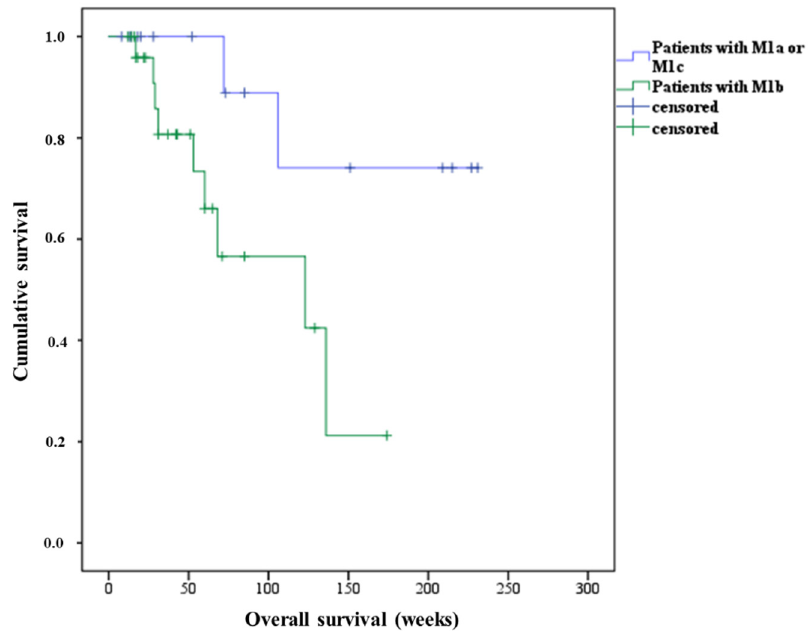
Figure 3. Kaplan–Meier plots using log-rank (Mantel–Cox) test illustrate overall survival of mCRPC patients treated with a second course of three cycles of PSMA-RLT. Male patients with bone metastasis (M1b) had significantly shorter survival compared to patients with lymph node (M1a) or visceral metastases (M1c), median survival 123 weeks vs. not reached, p = 0.03, 95% CI 2.42–243.